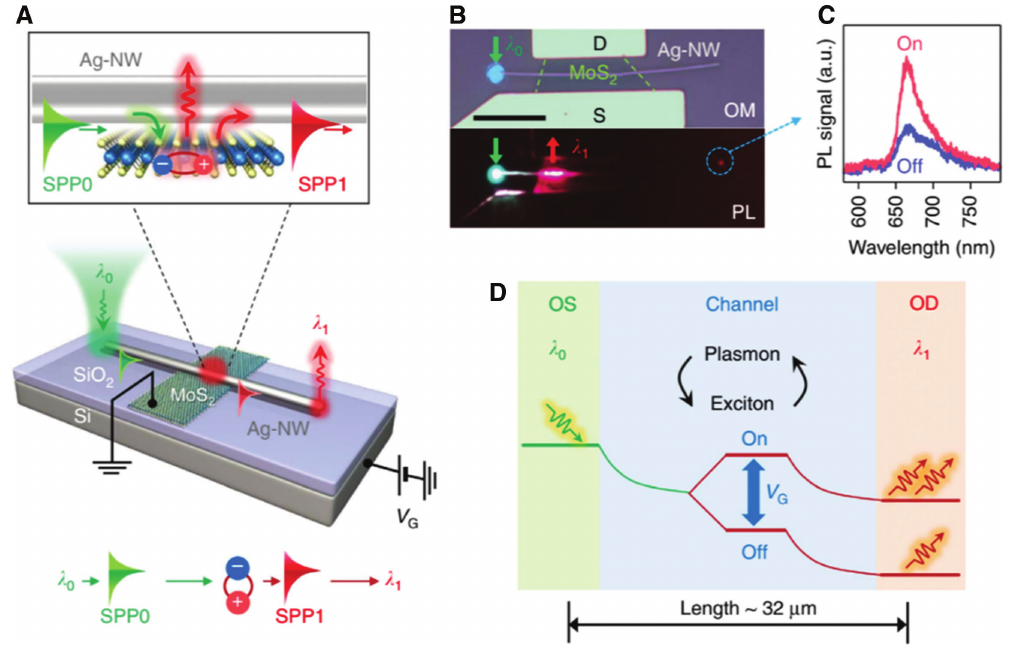
Figure 11: Long channel excitonic